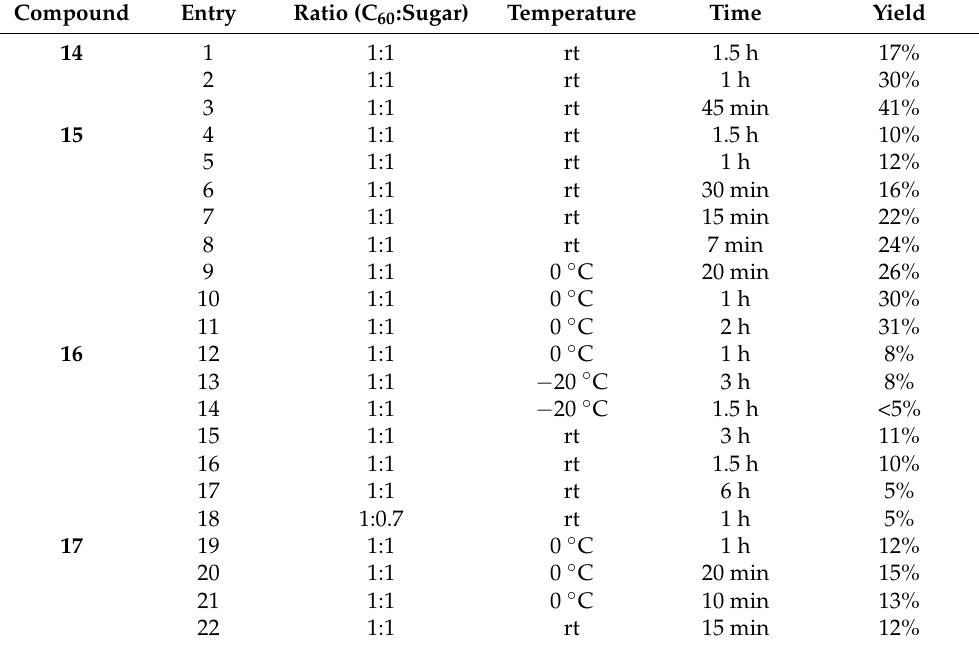
Table 1. Decoration of fullerene with sugar-modified malondiamide linkers: screening of the optimal reaction conditions.